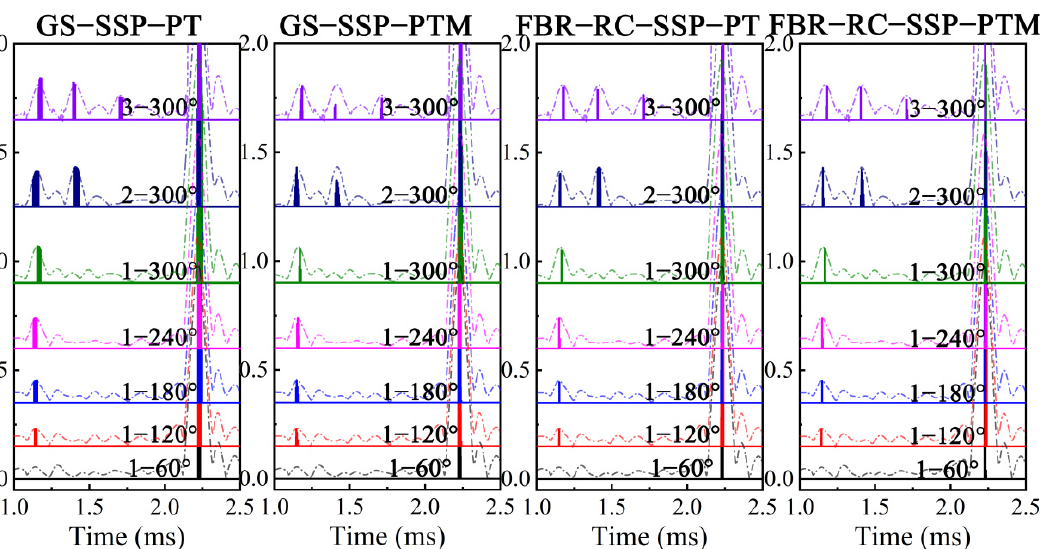
Figure 16. Experimental UGW signals with multi-defect (1 ≤ defect number ≤ 3, 60° ≤ α ≤ 300°).